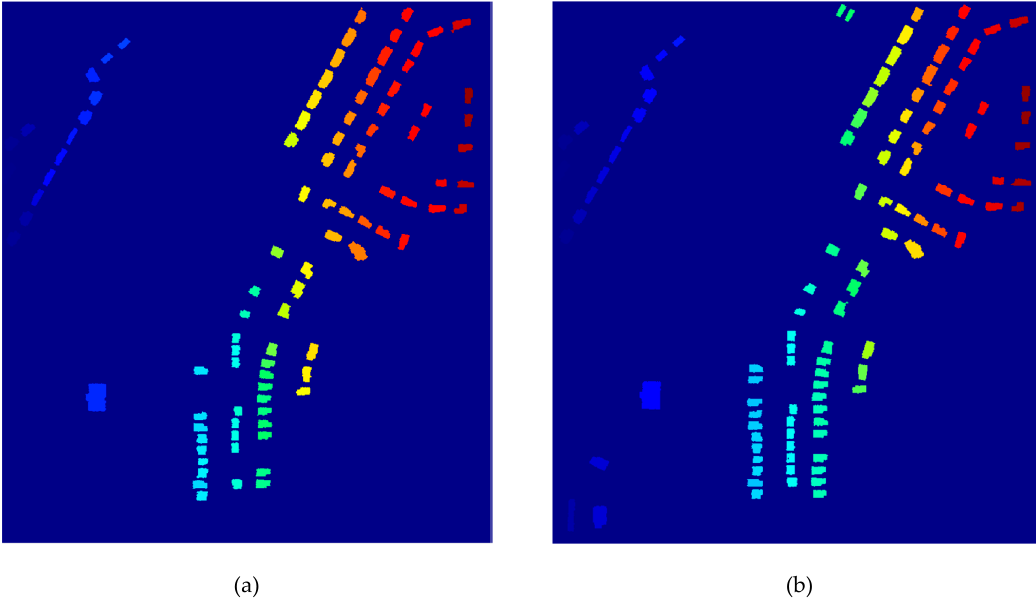
Figure 8. Buildings extracted from LiDAR data. ( a ) first data and ( b ) second data.